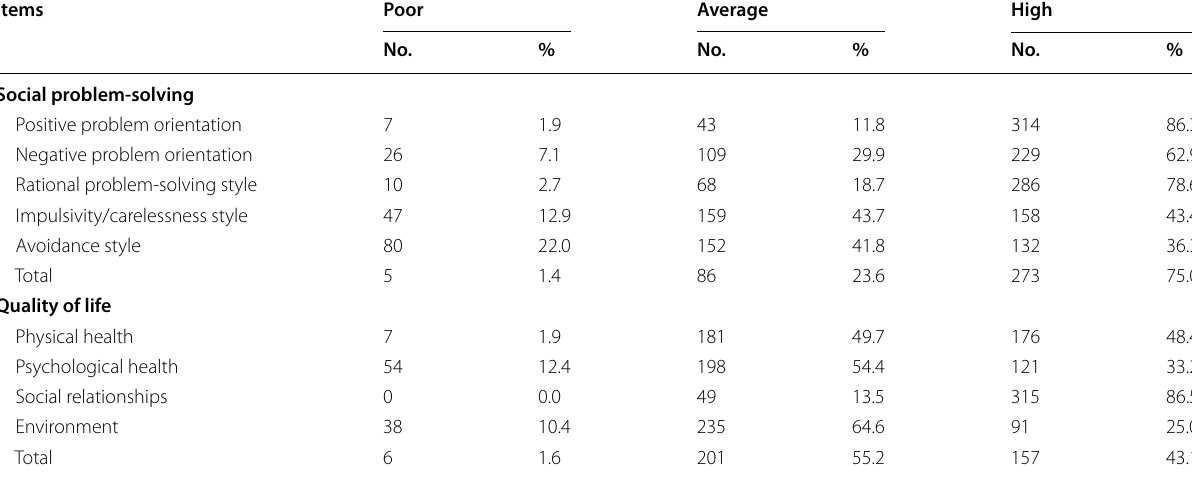
Table 4 Frequency distribution of the sample according to social problem-solving and quality of